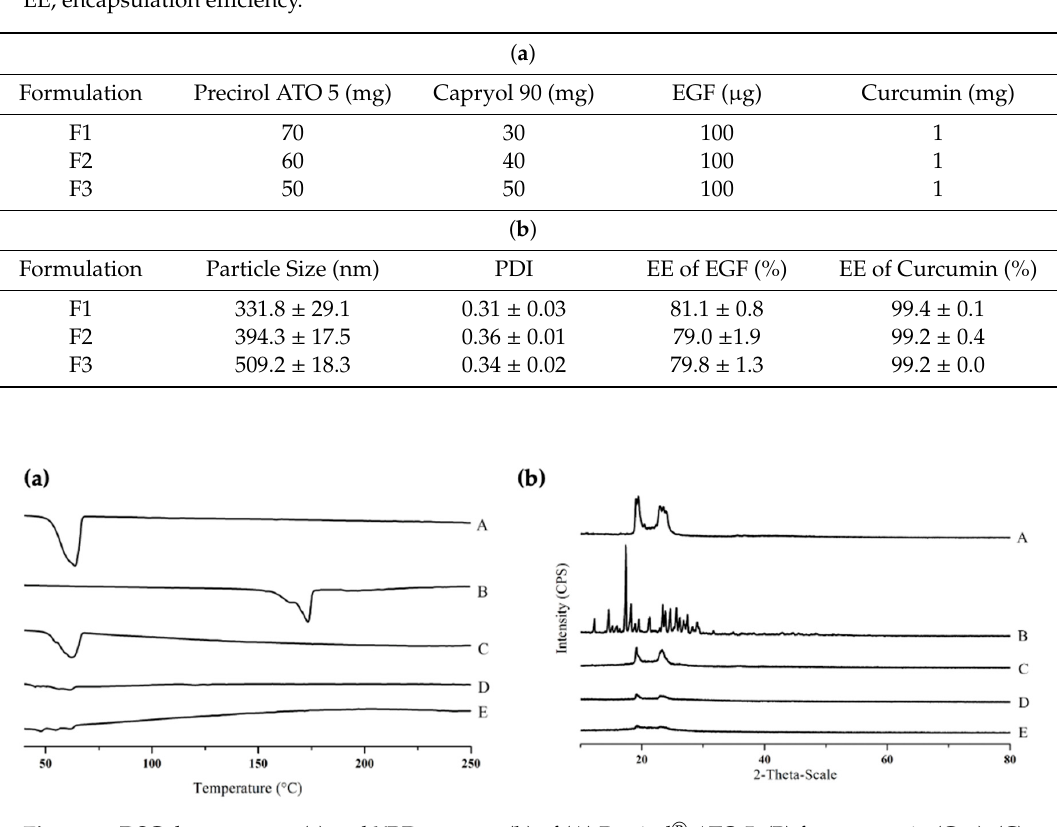
Figure 2. DSC thermograms ( a ) and XRD patterns ( b ) of (A) Precirol ® ATO 5, (B) free curcumin (Cur), (C) physical mixture, (D) blank nanostructured lipid carrier (NLC), (E) epidermal growth factor (EGF)–Cur-NLC.